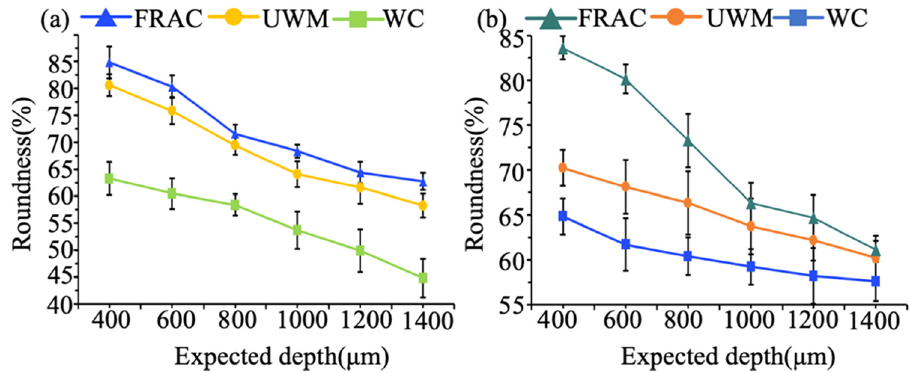
Figure 5: The roundness factor of blind holes: ( a ) tungsten steel electrode; ( b ) brass electrode; ( c ) copper electrode ( frequency = 120 kHz, pulse width = 3 µs, current = 2.5, voltage = 90 V, gain coe ffi cient = 15 )